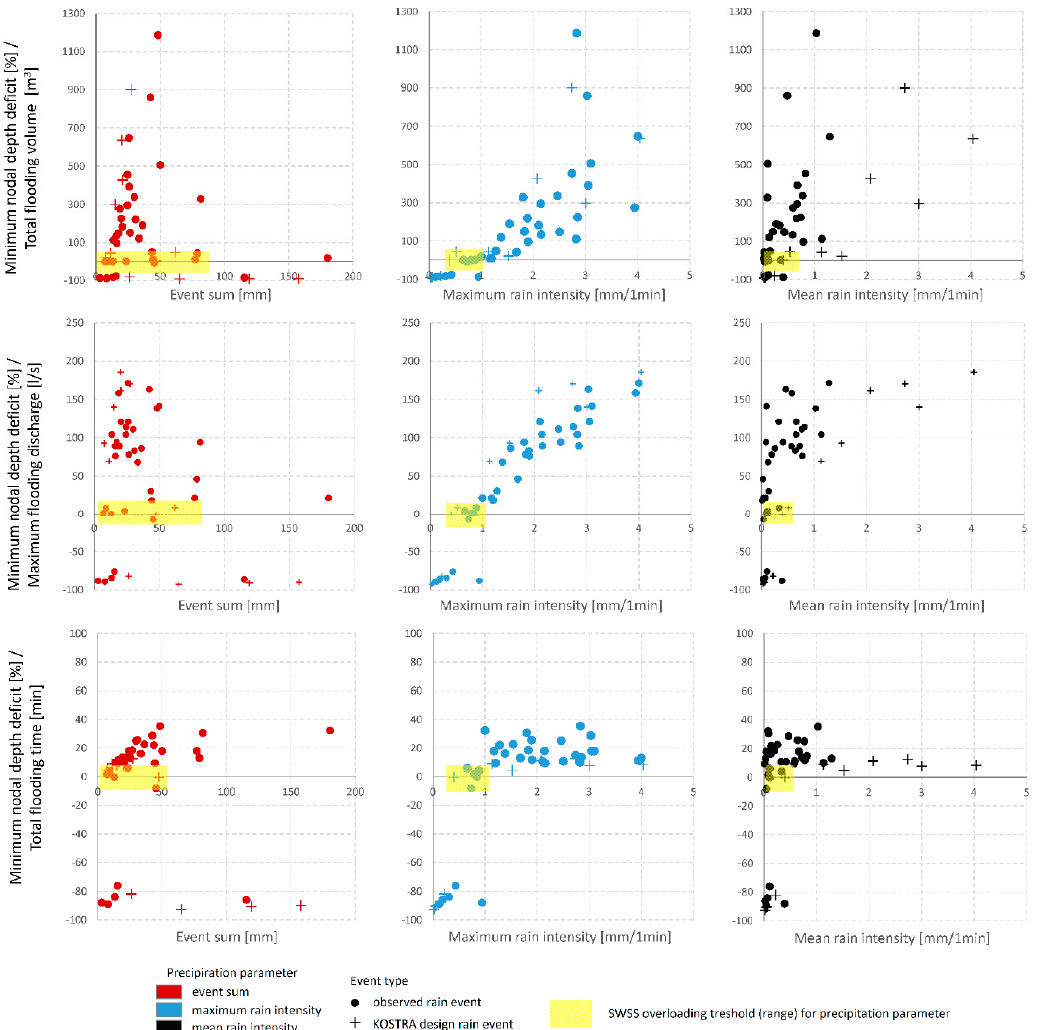
Figure 7. Graphical derivation of the threshold for SWSS overloading and its parameters based on precipitation parameters.